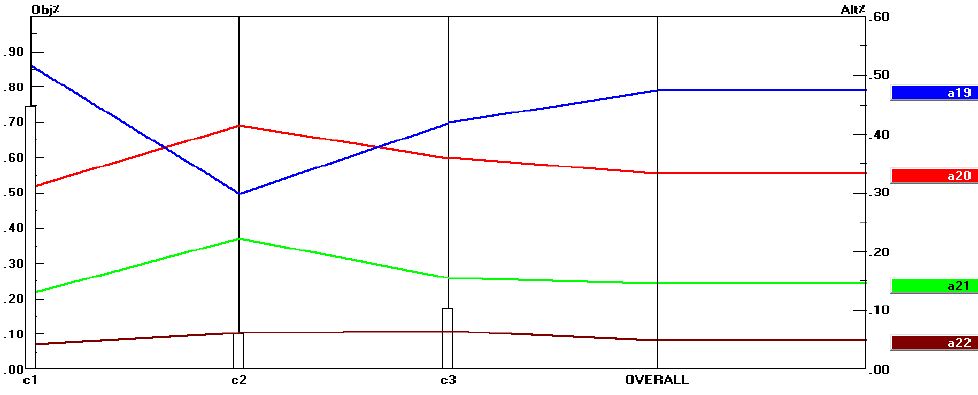
Fig. 9. The sensitivity analysis of indicators and suppliers for category C.